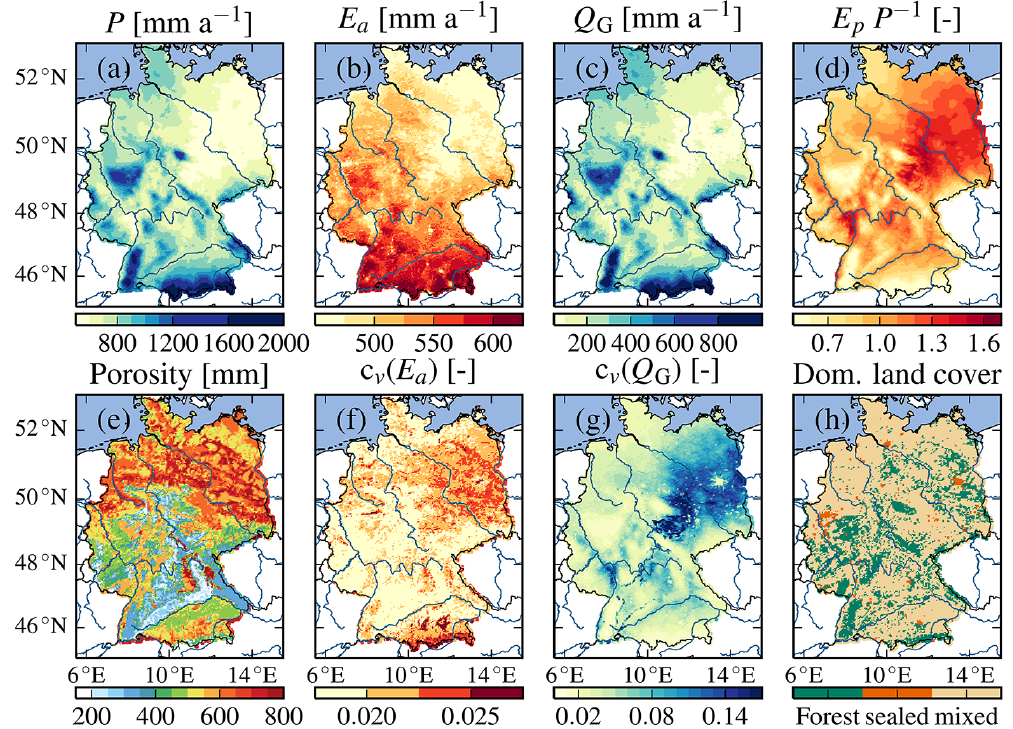
Figure 9. Water balance variables, their coefficients of variation, and land-surface characteristics for Germany. (a) Mean annual precipita- tion P , (b) ensemble mean annual evapotranspiration E a , (c) grid-cell-generated runoff Q G , (d) dryness index E p /P , (e) sum of porosities (saturated soil water content) of all model layers, (f) coefficient of variation of the ensemble of annual evapotranspiration and (g) gener- ated runoff, (h) dominating land cover class on a 4km × 4km grid. The mean values and coefficients of variation are based on the period